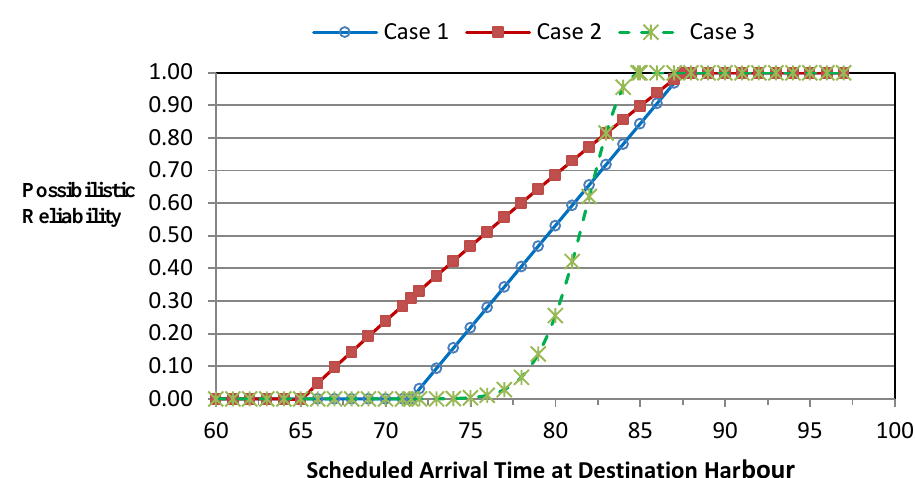
Figure 5. Variation of possibilistic reliability in all three cases.